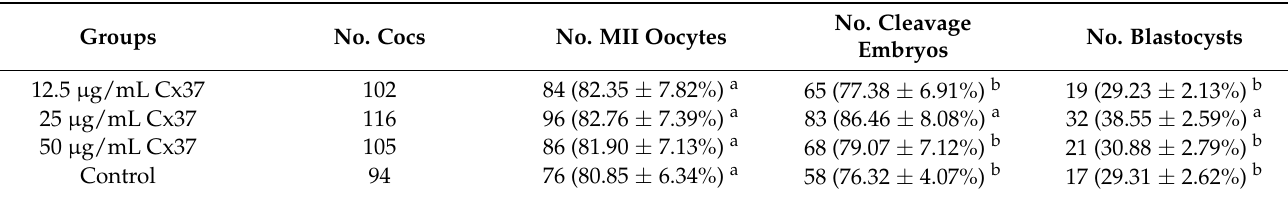
Table 4. Effect of Cx37 on the maturation and development ability of bovine oocytes. Groups No. Cocs